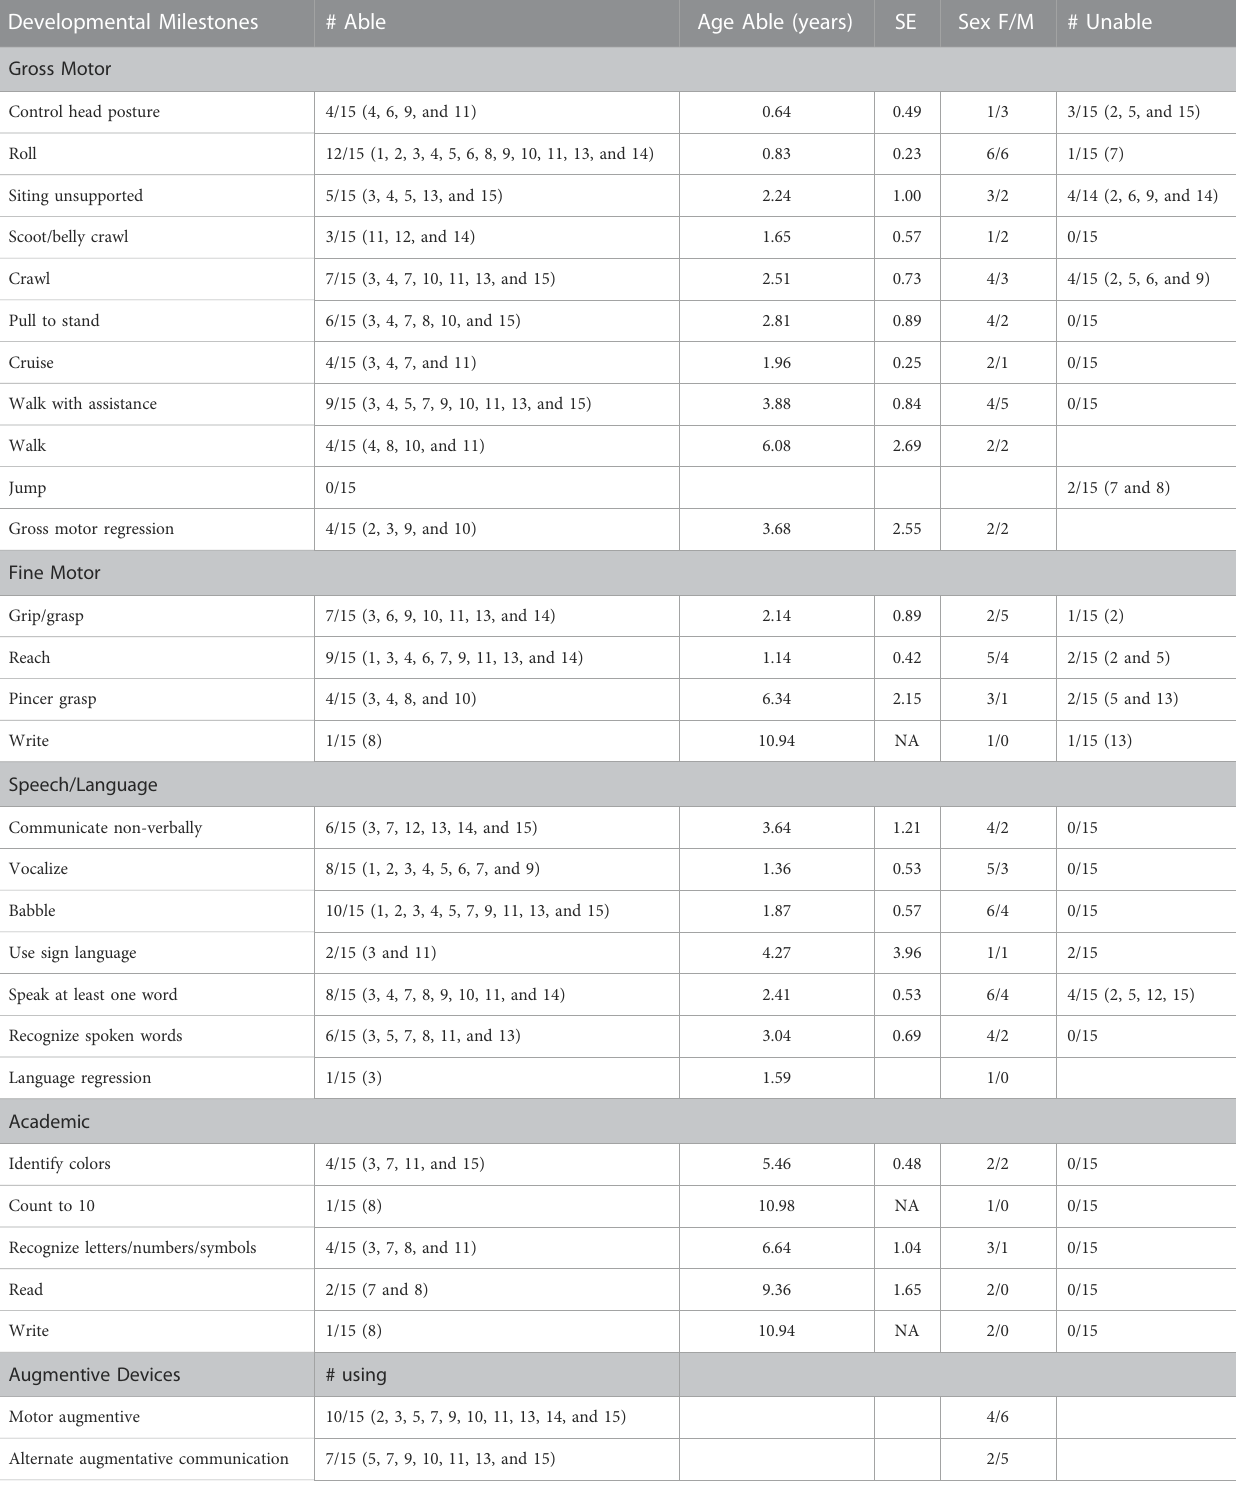
TABLE 2 Developmental milestone achievement and assistive device use. Summary description of developmental milestone achievement and the assistive device use for patients for whom these data were available in this dataset. Developmental milestones: The total number of patients recorded as able and which patientswereabletoachieveeachmilestonearelisted.Thenumberofpatientswhowereunabletoachievemilestones(i.e.,aspeci fi ccommentwasmadethatthe patienthadnotachievedthemilestone,andthepatientneverachievedthemilestonewithinavailabledata)isalsogiven.Forthosenotedasable,theaverageage at which the milestone was fi rst noted and the standard error are included, as well as sex. Assistive device use: Total number and speci fi c patients using assistive devices (motor or communication) are